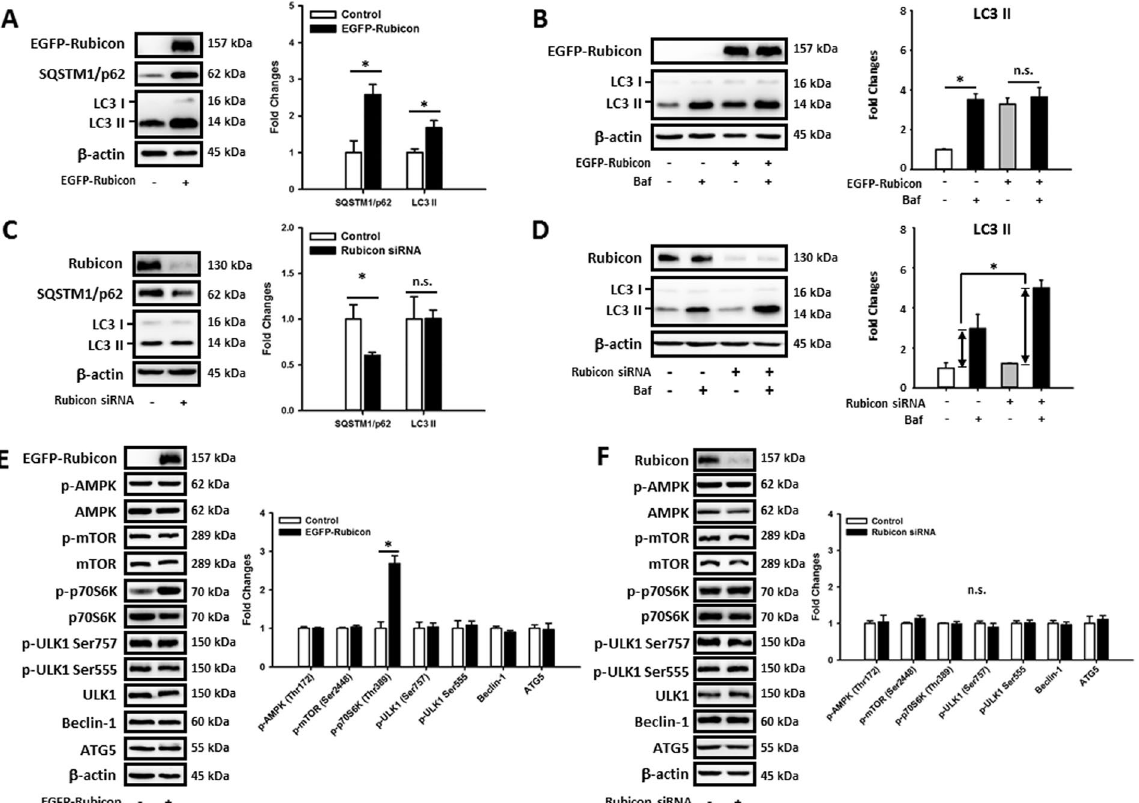
Figure 6. Rubicon inhibits late-stage autophagy activity in HepG2 cells independently of regulating the AMPK/ mTOR/ULK1 signaling pathway. To investigate the regulatory function of Rubicon on hepatic autophagy, we overexpressed or knocked down Rubicon in HepG2 cells by transfecting the EGFP-Rubicon plasmid or Rubicon targeting siRNA respectively. The Autophagic flux changes in Rubicon-overexpressed ( A and B ) or knocked- down cells ( C and D ) were analyzed using Western blotting. Representative immunoblots and densitometric results of phospho-AMPK (Thr172) phospho-mTOR (Ser2448), phospho-p70S6K (Thr389), phospho-ULK1 (Ser757), phospho-ULK1 (Ser555), Beclin1, ATG5 in Rubicon overexpressed ( E ) or knocked-down ( F ) HepG2 cells are shown. For densitometric analyses of Western blotting data, β -actin and total target protein (for phospho-proteins) were used as the loading controls. Values are mean ± SEM (n = 3). * P < 0.05. n.s.: no significant difference. Full-length blots are presented in Supplementary Figure